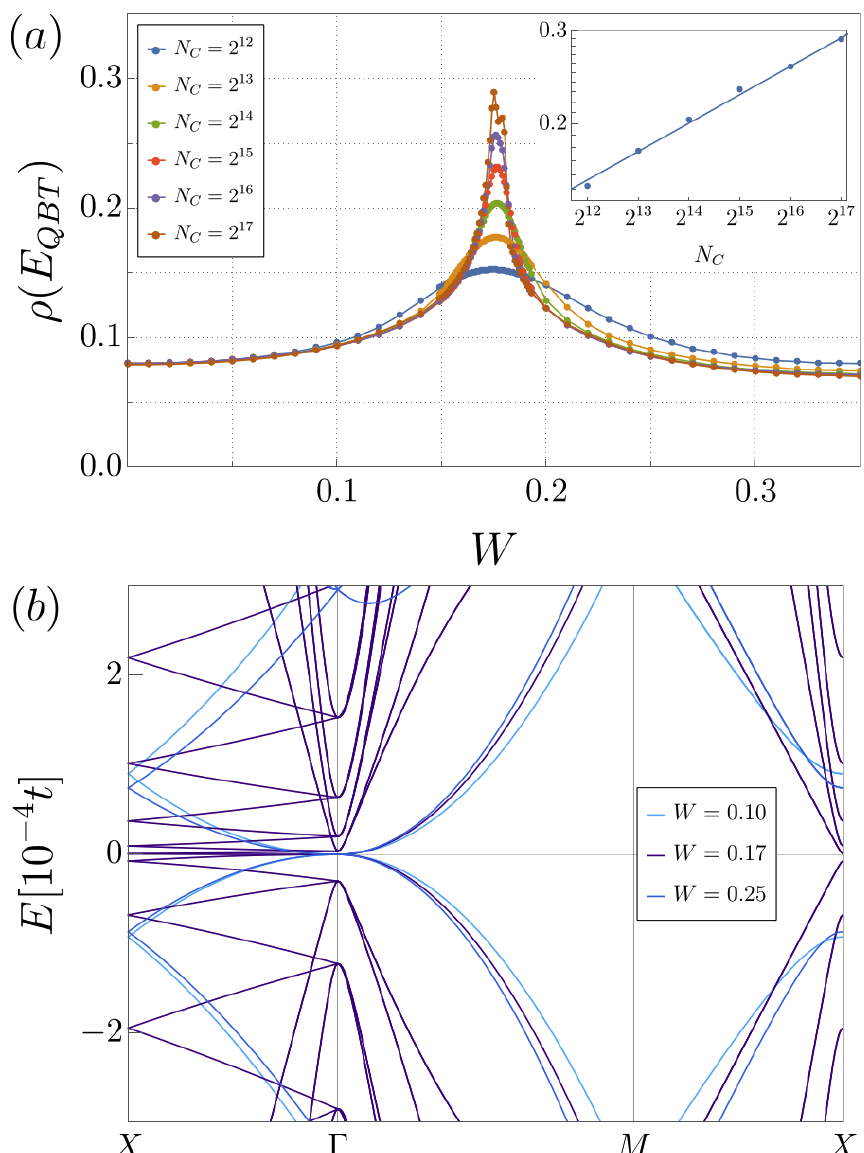
Figure 6: Diverging density of states and flat bands at the magic-angle : (a) The ρ ( E ) as a function of W for a number of different N ’s. The system size is L = 144 c QBT / 2 π = F / L . The inset shows the peak value scales as a and the wavevector is Q L 8 power law in N . (b) The dispersion of the same system for different W . This shows c the system in QBT phase, enters a point ( W = 0.17) where the band partially flattens, and re-enters the QBT